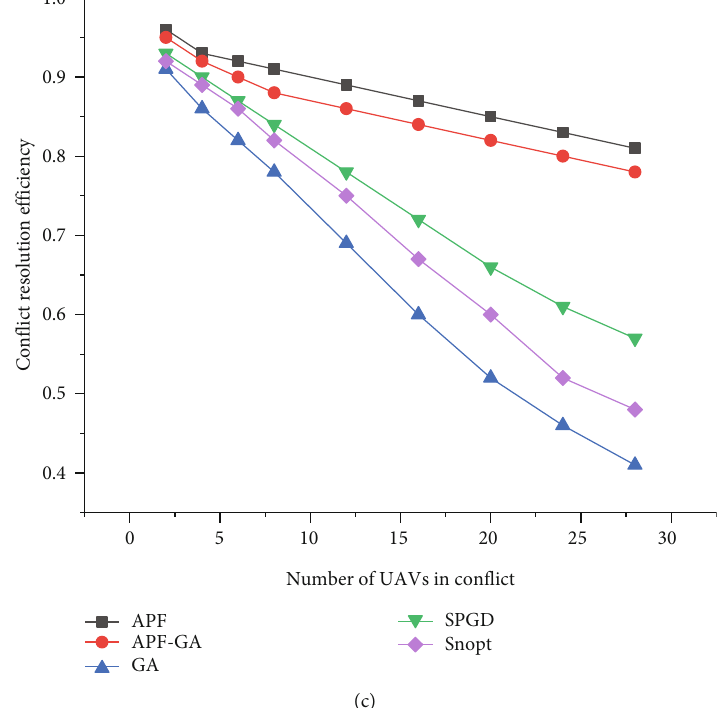
Figure 12: Performance comparison of con fl ict resolution solution strategies: (a) computing time, (b) feasibility, and (c) con fl ict resolution e ffi ciency comparisons.